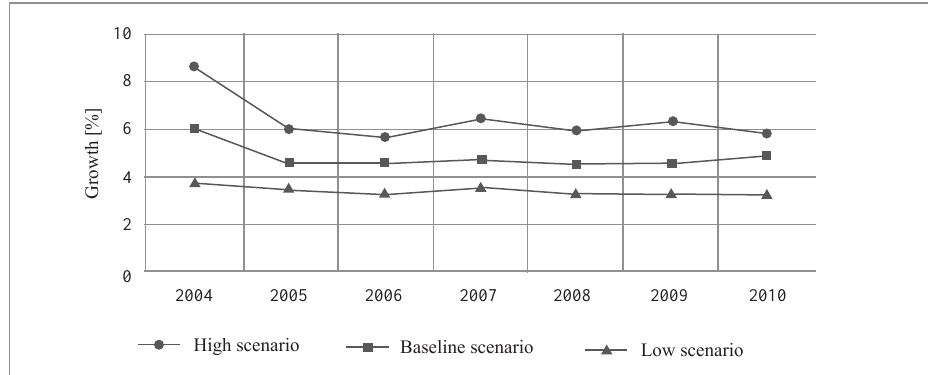
Fig. 2. Annual growth of IFR flights forecast